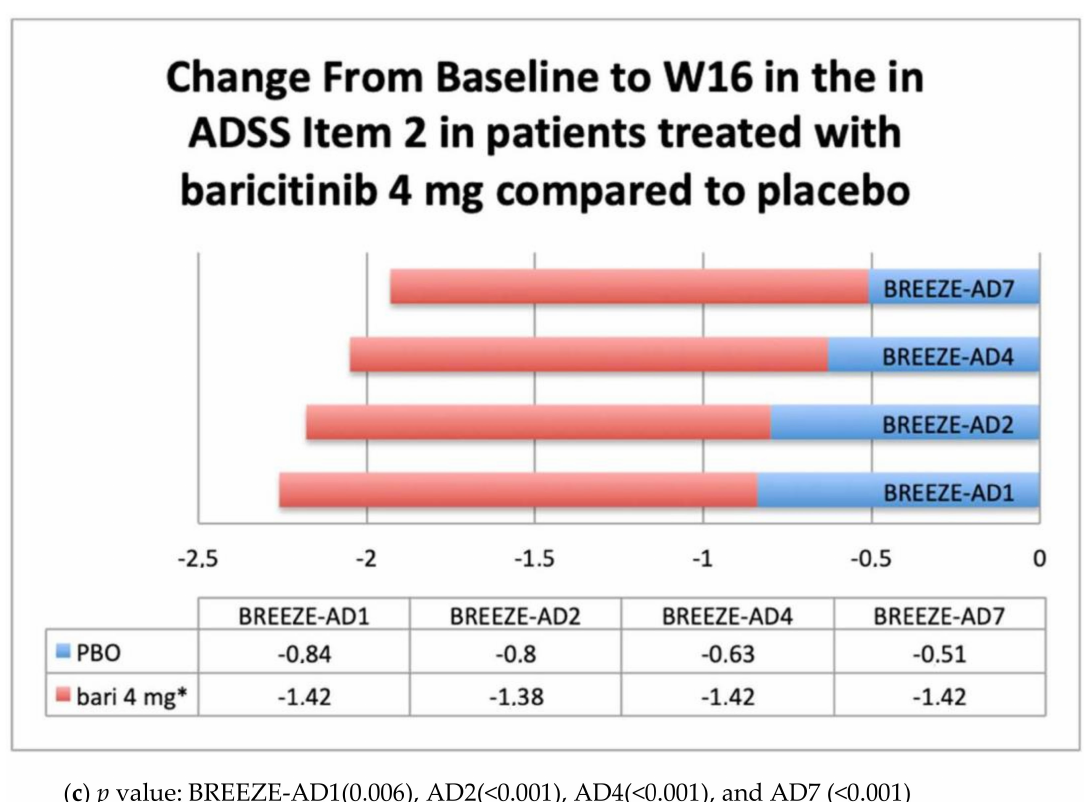
Figure 5. ( a ) PROs endpoints from the BREEZE-AD1, AD2, AD4, and AD7: Proportion of patients treated with baricitinib 4 mg achieving ≥ 4-point improvement in Itch NRS from baseline at W16 compared to placebo. Abbreviations: PBO, placebo; NRS, Numeric Rating Scale; W16, week 16; bari, baricitinib. * In BREEZE-AD4 and AD7, baricitinib was administered in association with topical corticosteroid as for protocol. ( b ) PROs endpoints from the BREEZE-AD1, AD2, AD4, and AD7: Change from Baseline to W16 in the Dermatology Life Quality Index (DLQI) in patients treated with baricitinib 4 mg compared to placebo. Abbreviations: PBO, placebo; DLQI, Dermatology Life Quality Index; W16, week 16; bari, baricitinib. * In BREEZE-AD4 and AD7, baricitinib was administered in association with topical corticosteroid as for protocol. ( c ) PROs endpoints from the BREEZE-AD1, AD2, AD4, and AD7: Change from Baseline to W16 in the in ADSS Item 2 in patients treated with baricitinib 4 mg compared to placebo. Abbreviations: PBO, placebo; ADSS, Atopic Dermatitis Symptom Score; W16, week 16; bari, baricitinib. * In BREEZE-AD 4 and AD7, baricitinib was administered in association with topical corticosteroid as for